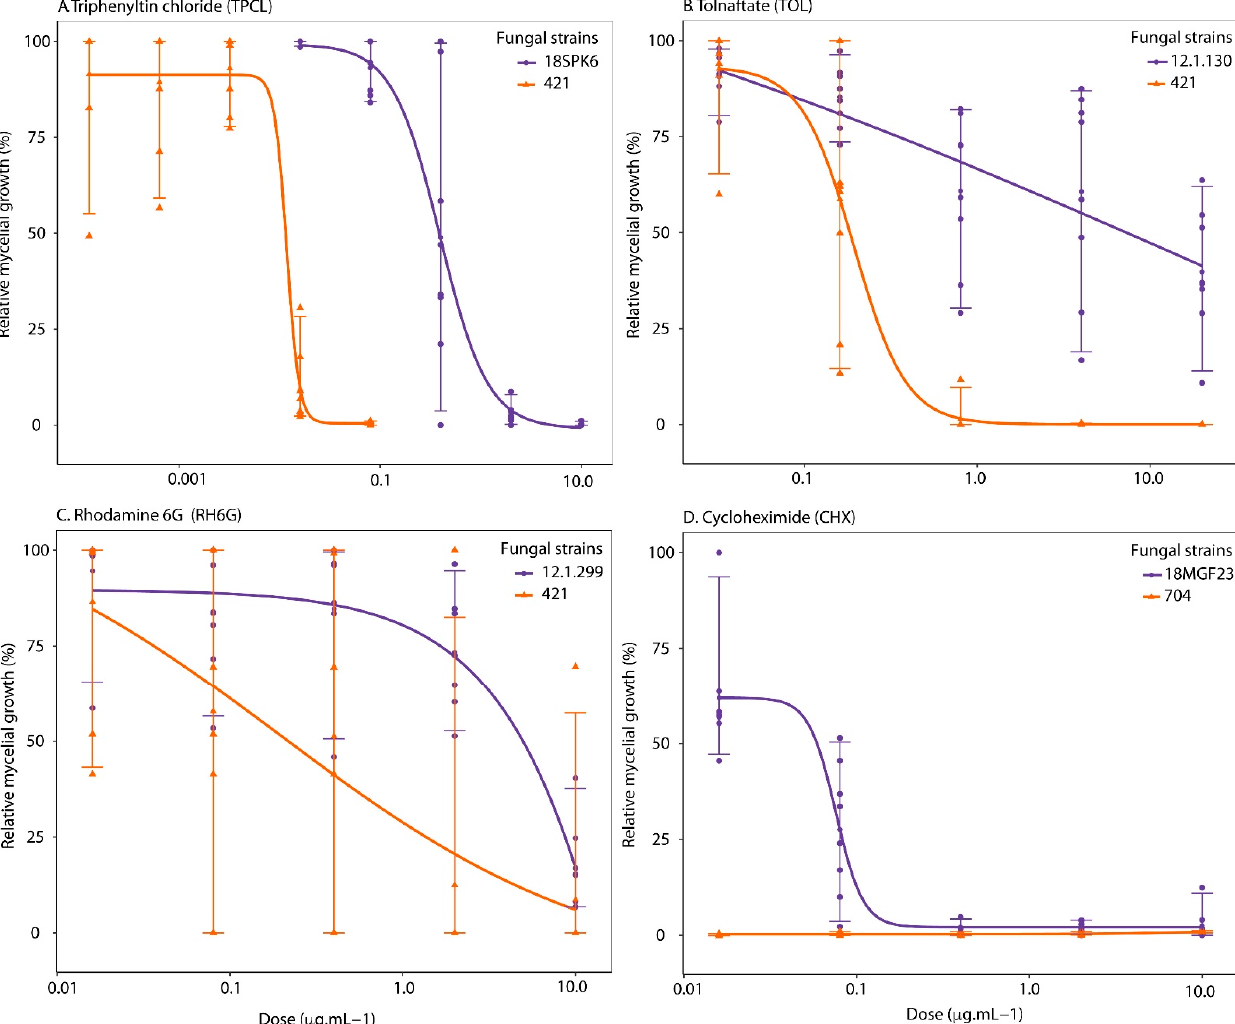
Figure 1. Contrasting in vitro relative growth of Pyricularia oryzae Triticum and Oryza lineages in different efflux pump substrates in PD broth on a microplate assay. ( A ). Triphenyltin chloride (TPCL)-resistant strain 18SPK6 from P. oryzae Triticum lineage ( PoT l), and the sensitive strain 421 from P. oryzae Oryza lineage ( PoO l). ( B ). Tolnaftate (TOL)-resistant PoTl 12.1.130 and the sensitive strain PoO l 421. ( C ). Rhodamine 6G (RH6G)-resistant strain PoT l 12.1.299 and the sensitive strain PoO l 421. ( D ). Cycloheximide (CHX)-resistant strain PoT l 18MGF23 and the sensitive strain PoO l 704. Bars contain the sample median and outer quantiles at 95% confidence interval (the 2.5th and the 97.5th percentiles as the lower and the upper confidence limits). Data points are distributed along the